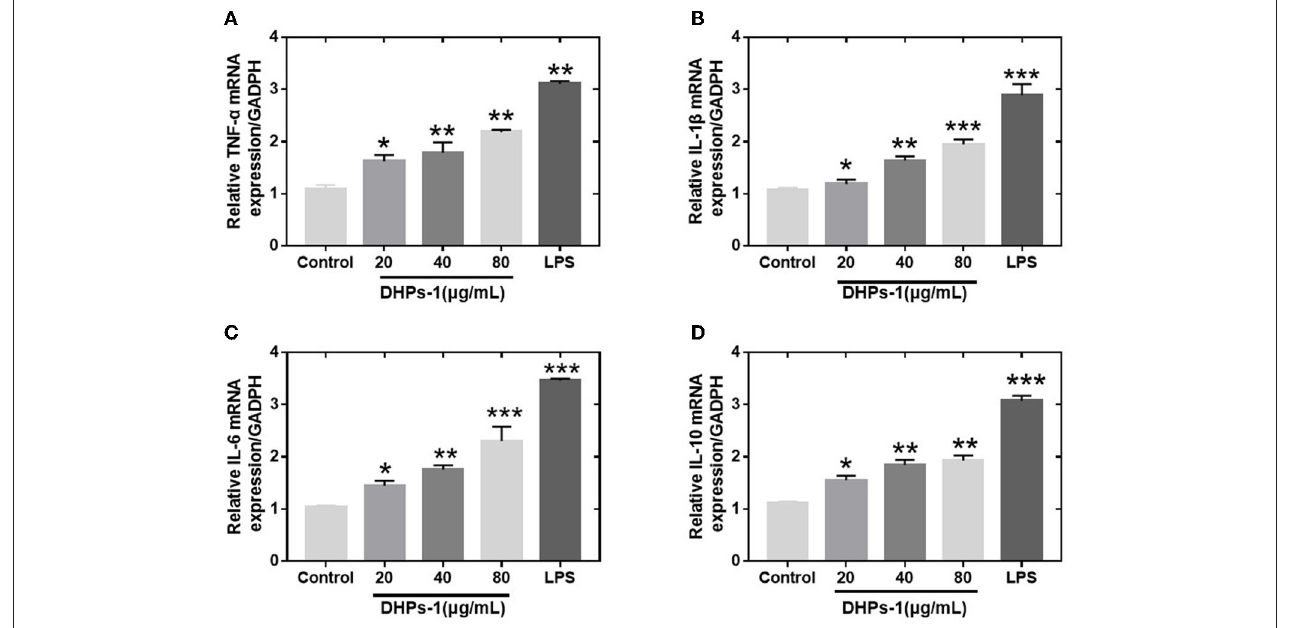
FIGURE 7 | Effects of DHPs-1 on the expression of cytokine genes in RAW264.7 cells (A–D) : Expression of TNF- α (A) , IL-1 β (B) , IL-6 (C) , and IL-10 (D) mRNA in RAW264.7 cells treated with DHPs-1 or LPS groups for 12h. Significant differences from control group are denoted by * p < 005, ** p < 0.01, *** p <